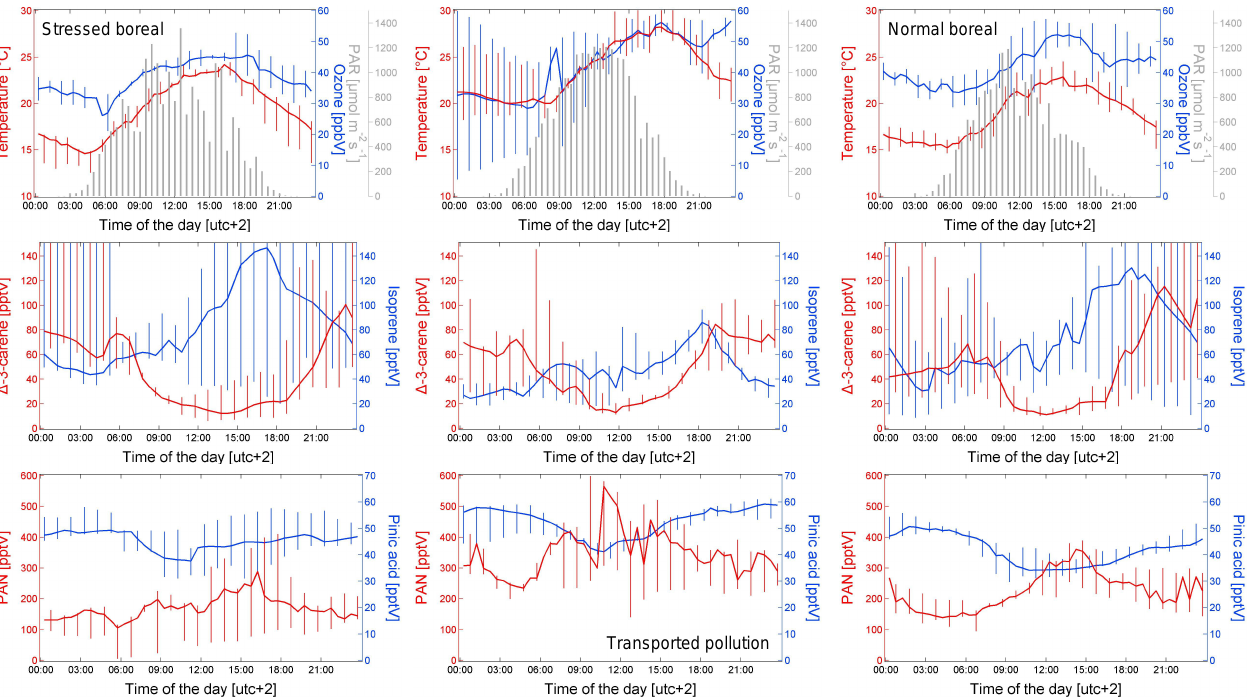
Fig. 5. Median diel variation for several measured parameters during HUMPPA-COPEC 2010 in stressed boreal, transported pollution and normal boreal forest conditions. Temperature, O 3 mixing ratios and PAR are presented in the first row for all regimes. The second row pictures the diel variation of primary biogenic emissions ( 1 -3-carene and isoprene) and the lowermost row shows secondary products such as PAN and pinic